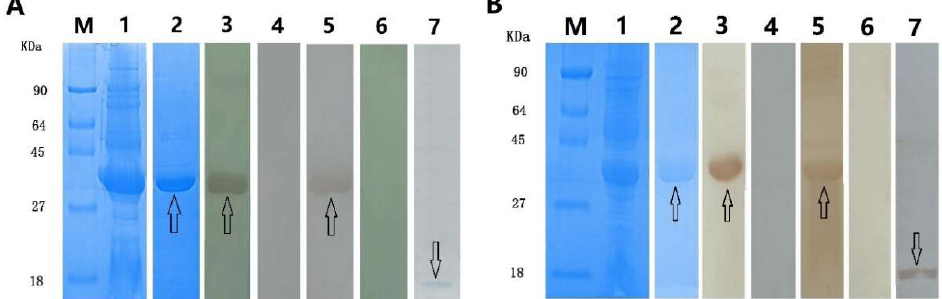
Figure 3. SDS-PAGE and Western blotting analysis of rEg-Fis1 and rEg-PDCD6. ( A ) Immune recognition of rEG-Fis1; ( B ) Immune recognition of rEG-PDCD6. M, molecular mass markers (kDa); lane 1, total proteins